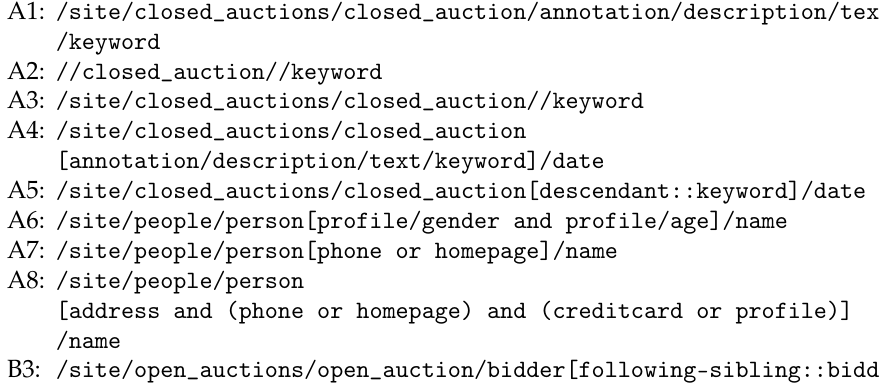
Figure 5. XPath benchmark